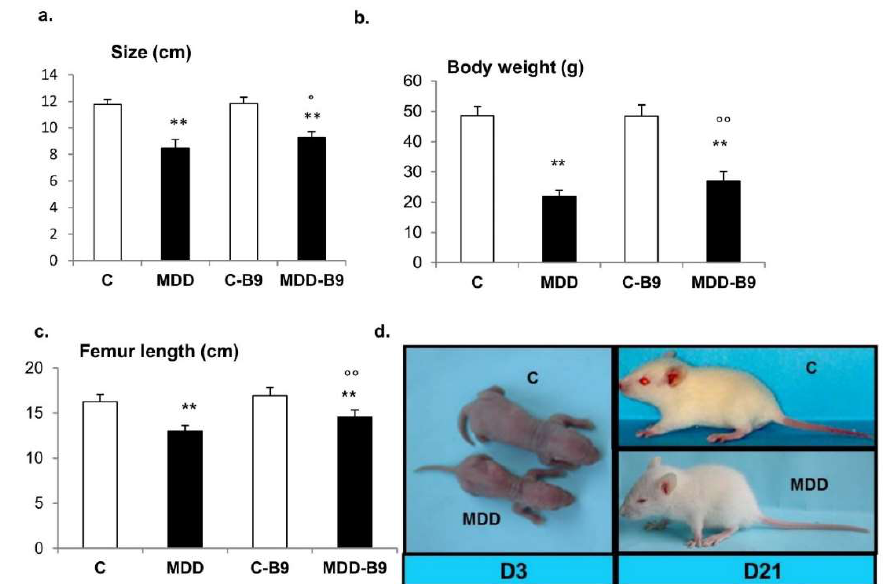
Figure 2. Effects of maternal methyl donor deficiency and folic acid supplementation on rat pup morphometric properties. ( a – c ) General morphometric measurements in control (C), methyl donor deficient (MDD), supplemented control (C-B9) and supplemented deficient (MDD-B9) rat pups at 21 days of age (20 ≤ n ≤ 40). Data are reported as mean ± standard deviation. Statistically significant differences between control and MDD rats: ** p < 0.01, between MDD and supplemented MDD: ° p < 0.05 and °° p < 0.01; ( d ) Illustration of MDD-associated growth retardation at 3 and 21 postnatal days.